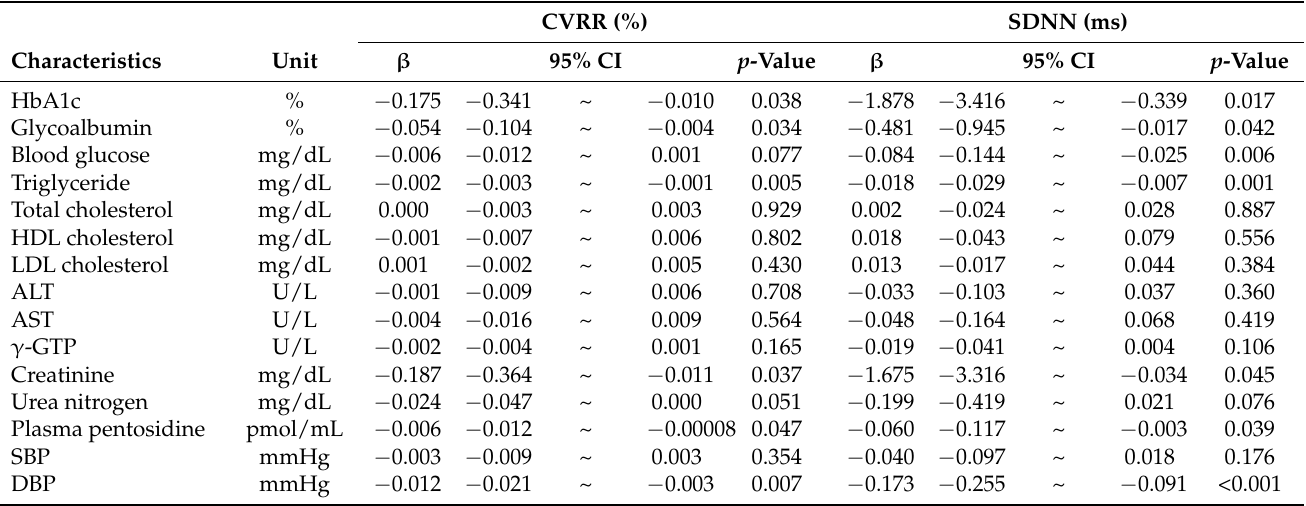
Table 4. Multivariate analysis of association with CVRR and SDNN (Model